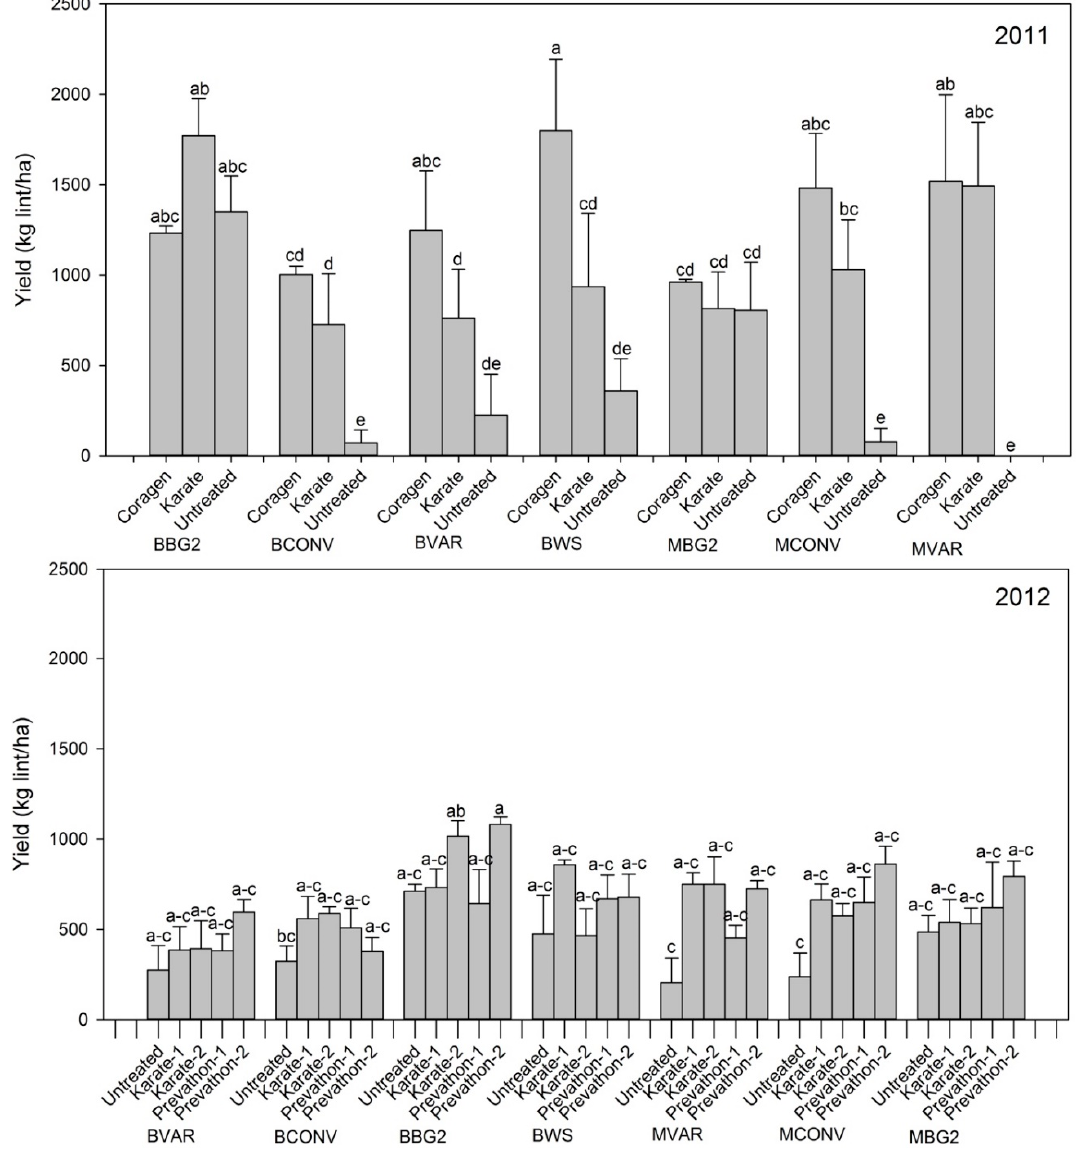
Figure 3. Total final yield (kg lint/ha) in 2011 and 2012 cage studies (data bars labeled with similar letters do not differ significantly ( p = 0.05), Tukey’s HSD test).